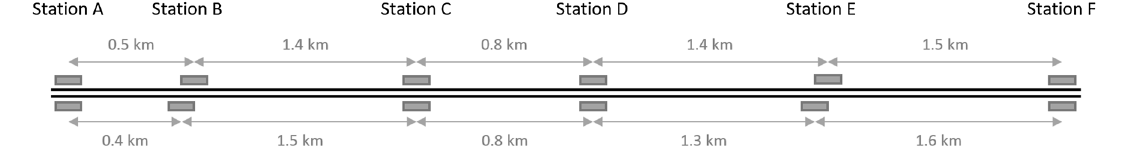
Fig. 7 Example network to illustrate sequence-based classification algorithm